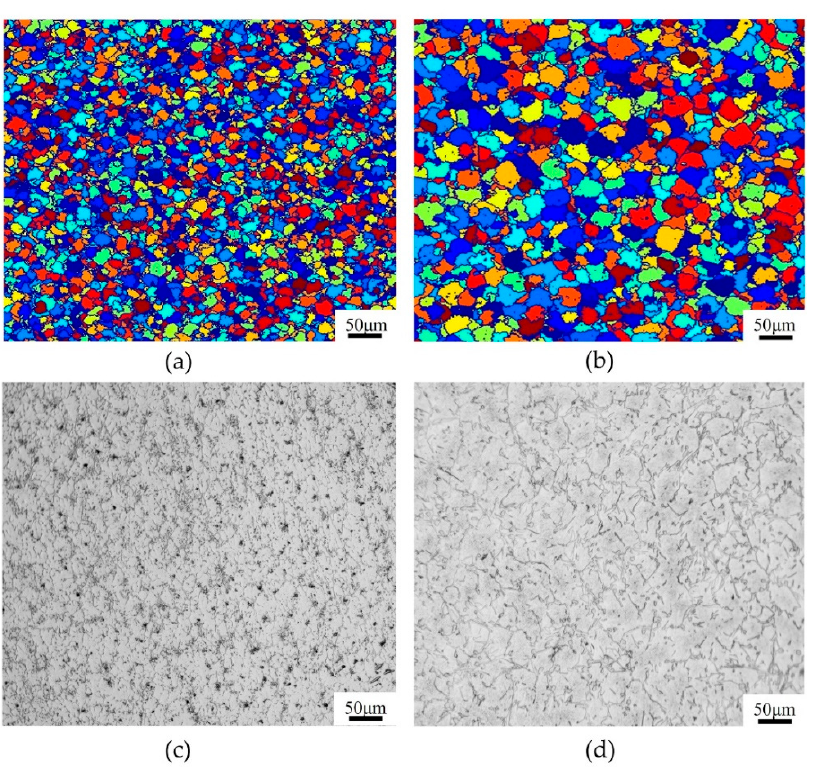
Figure 13. Comparisons of microstructure between simulated results and experimental ones with a true strain of 0.9 at the temperature of 1373 K and different strain rates of ( a , c ) 1.0 s − 1 ; ( b , d ) 0.01 s − 1 . The object of thermal deformation (viz., hot working) is to eliminate microstructure defects and refine grains. As noted above, a higher temperature or lower strain rate causes grain coarsening, while a lower temperature or higher strain rate may lead to an inadequate are desirable. As far as the above image results are concerned, the microstructure